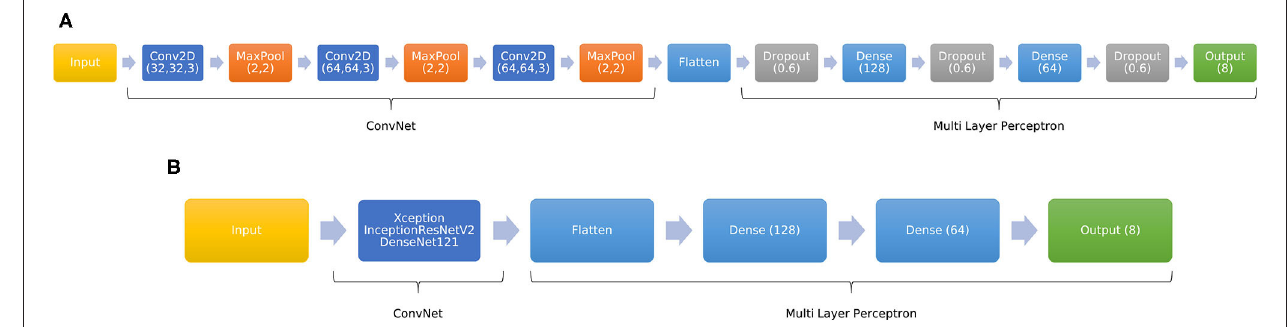
FIGURE 3 | Schematic overview of the CNN-based proposed architectures. (A) Custom CNN. (B) Adaptation of pre-trained network to a 8-unit